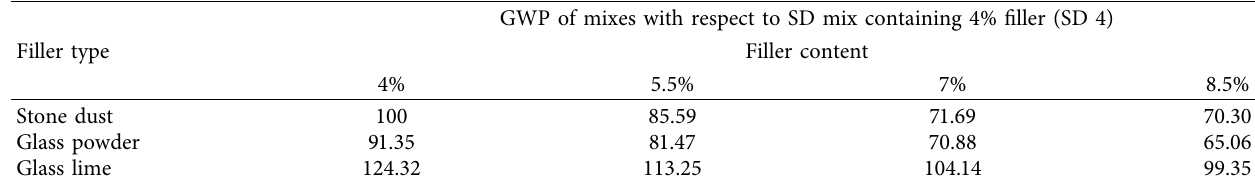
Table 10: Comparison of GWP of different